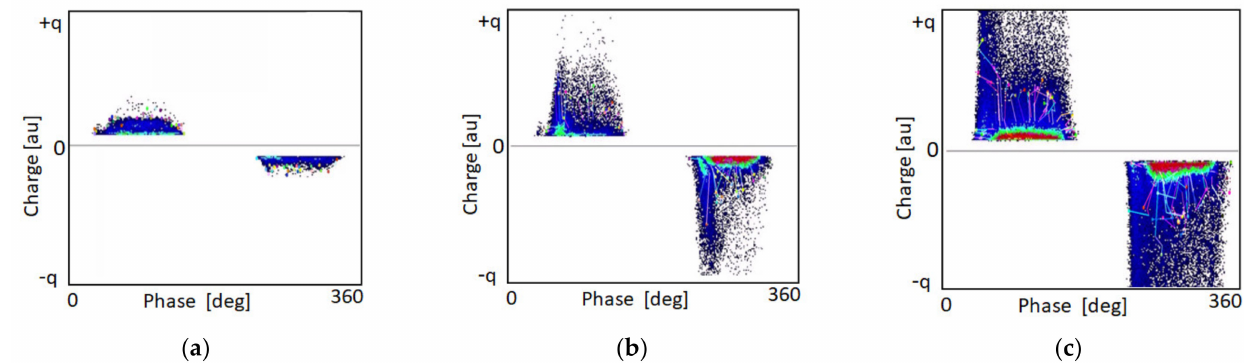
Figure 15. Detection of motion in partial discharge images in monitoring observations: ( a ) discharges on droplet surface at the initial phase; ( b ) more-intensive corona and surface discharges; ( c ) superimposed dry-band arcing and strong surface